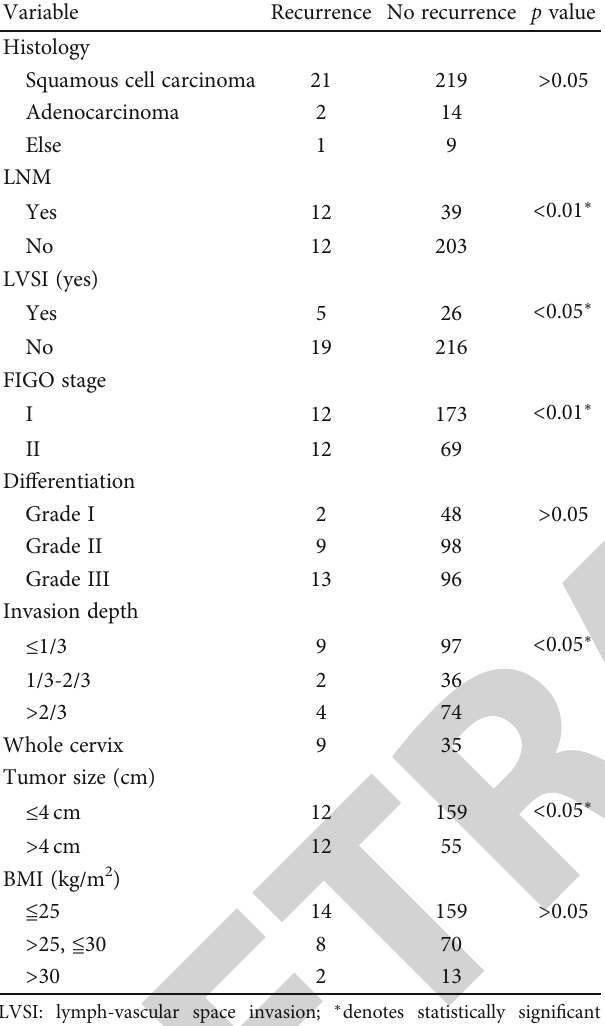
Table 4: The relationship between recurrence and clinical pathological